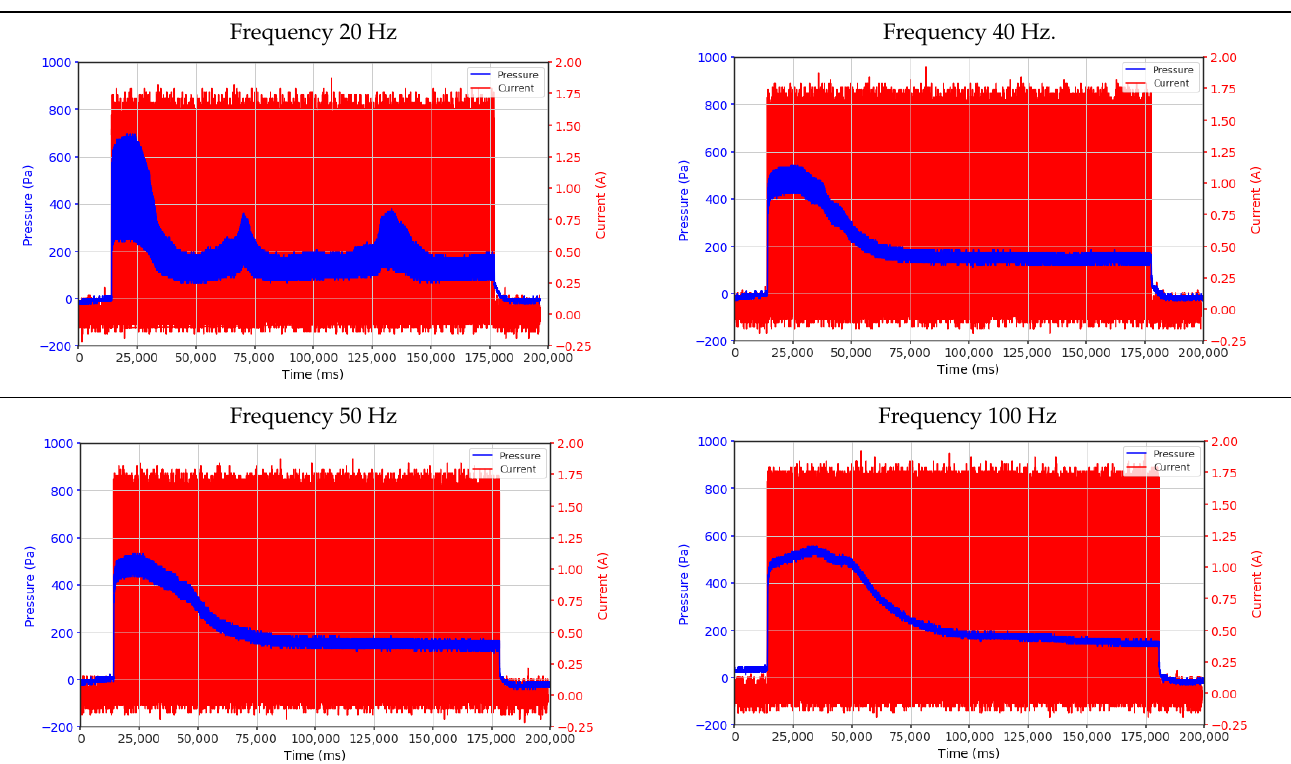
Table 3. The results of continuous observations of the application of 1.5 A current at frequencies above 10 Hz on the MRF.